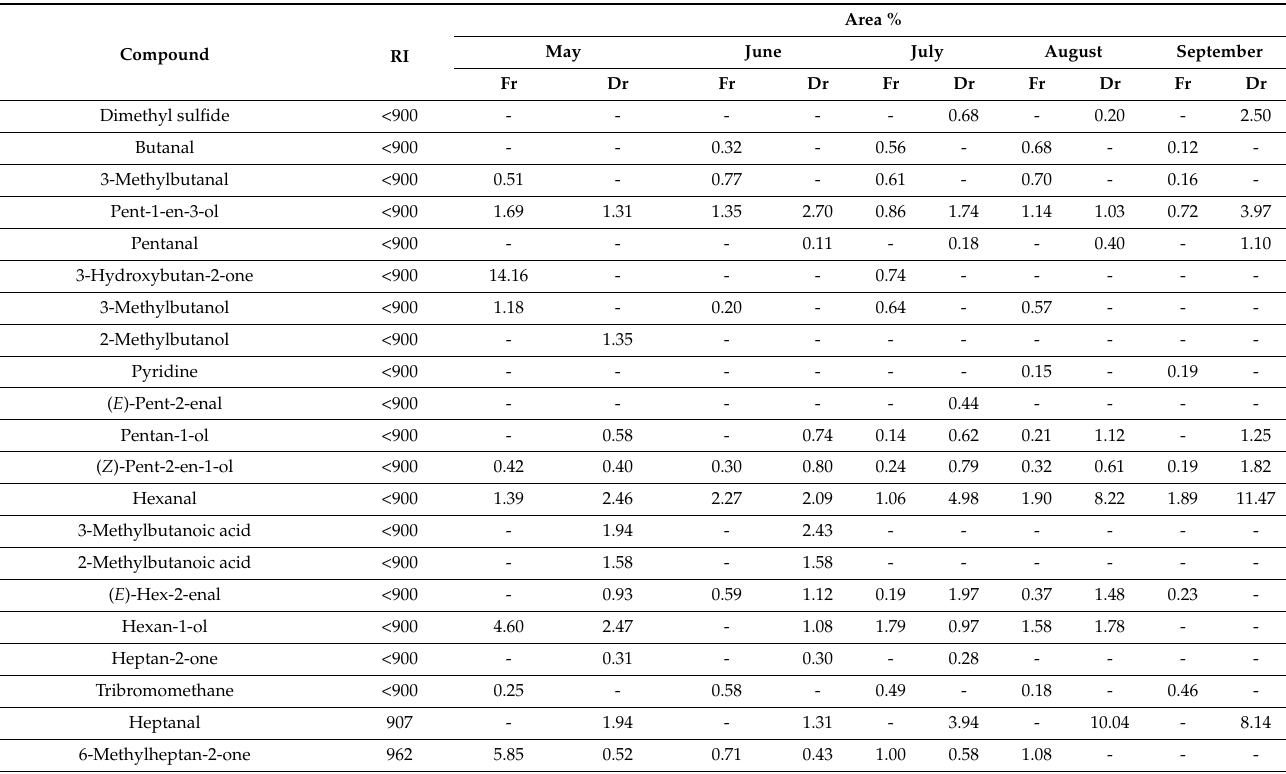
Table 2. The volatile compounds from H. scoparia isolated by headspace solid-phase microextraction (HS-SPME) and analysed by gas chromatography–mass spectrometry (GC–MS) using PDMS/DVB fibre (f2); Fr (fresh), Dr